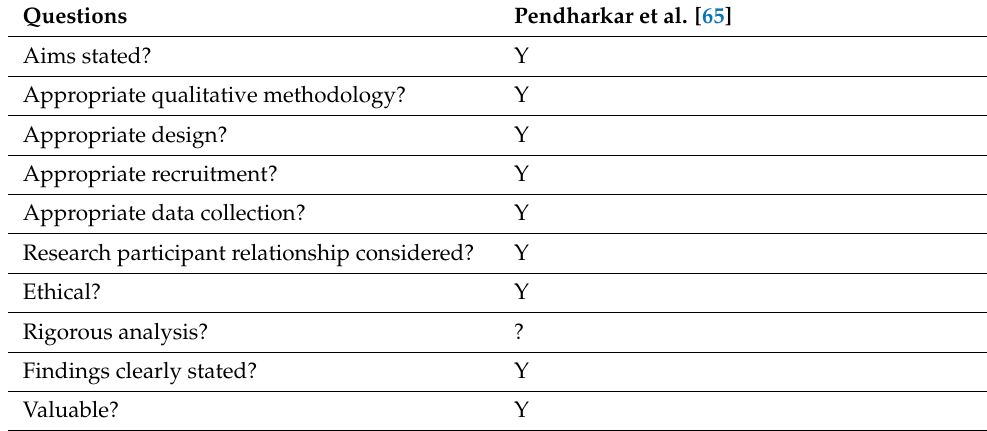
Table A4. Qualitative study